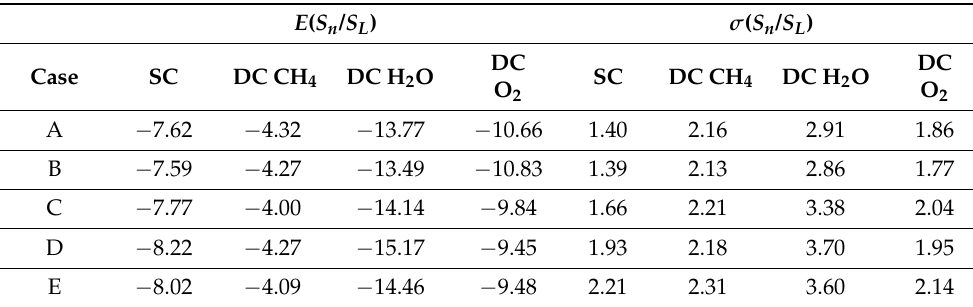
Table 7. Mean value E and standard deviation σ of normalised displacement speed S n / S L for the c = 0.8 isosurface value for all cases.